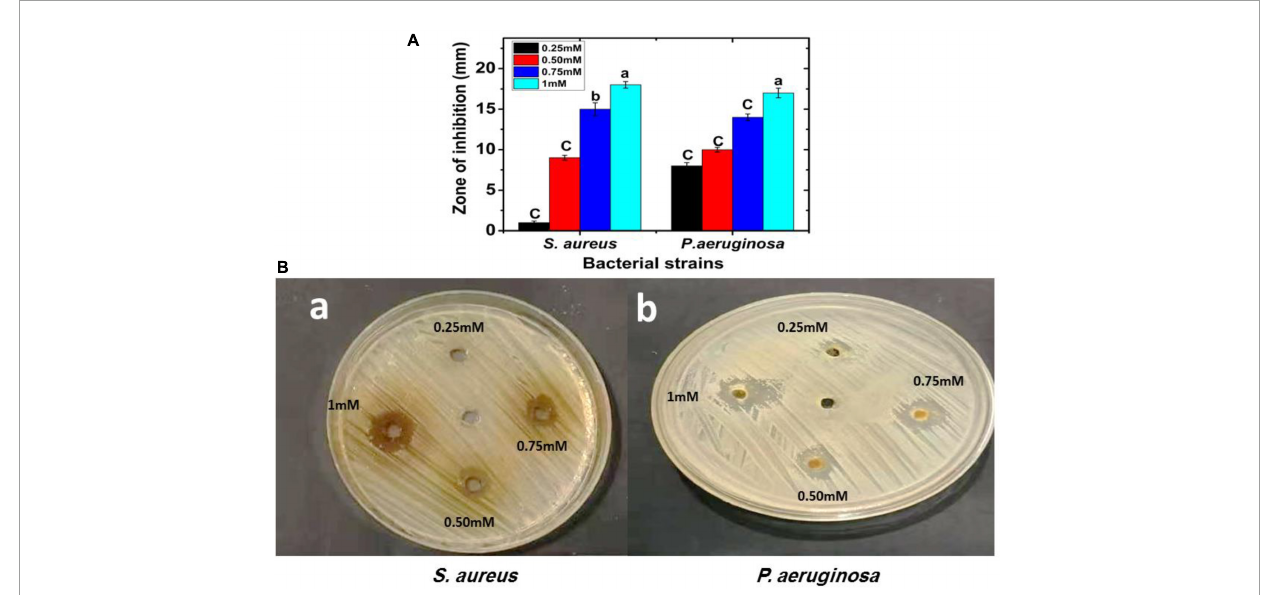
FIGURE7 FA-AgNPs inhibit P. aeruginosa and S. aureus bacterial growth; the inhibitory effect of FA-AgNPs compared to control were determined in vitro by agar well diffusion assay; (A) zone of inhibition (mm) carve. Values in each column followed by different letters are significantly different a , b ( P < 0.05). Statistical differences between samples in Duncan test; (Ba,b) S. aureus and P. aeruginosa bacterial zone of inhibition (mm) plate with different concentrations 0.25, 0.50, 0.75, and 1 mM of FA-AgNPs.